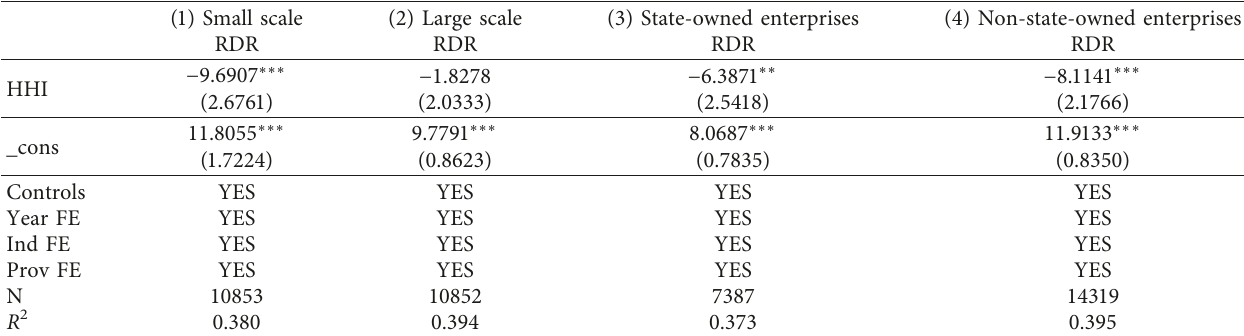
Table 5: Heterogeneity analysis results of